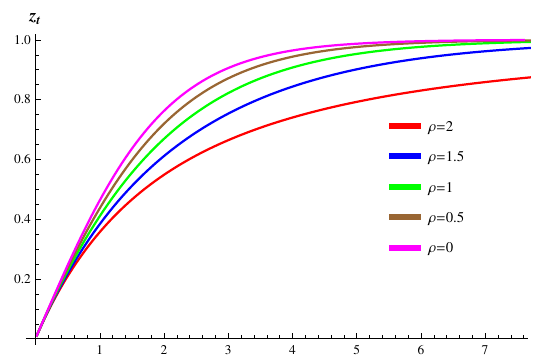
Figure 7. Plot of z t vs l for different values of ρ